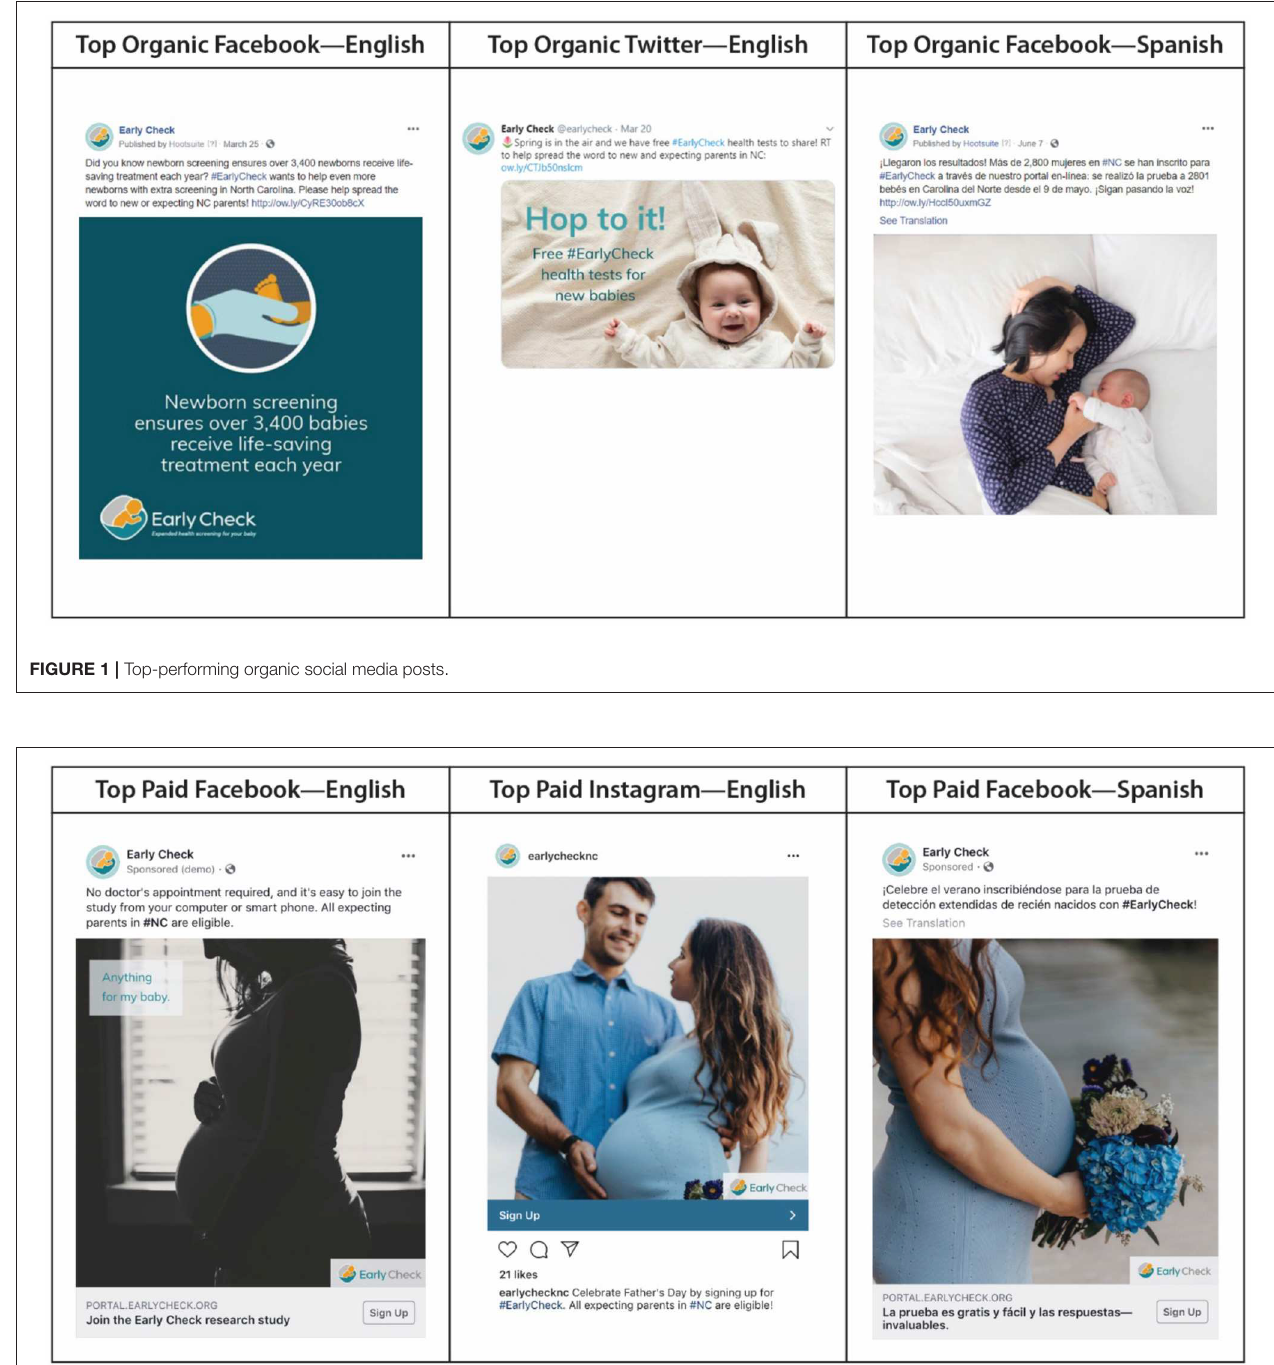
users and resulted in 254 link clicks (1.5% of people exposed to ads clicked on the link). Because of the low overall performance of the Instagram Spanish-language campaign, a top post could not be